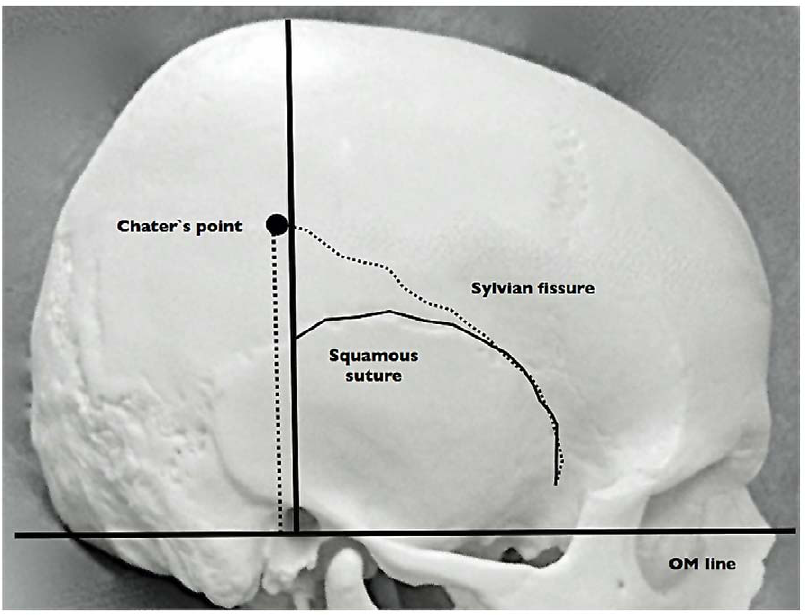
Figure 3. Illustrative methods of comparative measurement of Chater’s point and Squamous suture. Orbitomeatal (OM) line is drawn to define the base of measurement. Perpendicular line to EAM is drawn, and is regarded as horizontal 0 cm. Small-dotted line is showing the sylvian fissure. Curved-black line is SS. Bigger dotted line is showing the presumed position of CP, 6 cm from EAM.